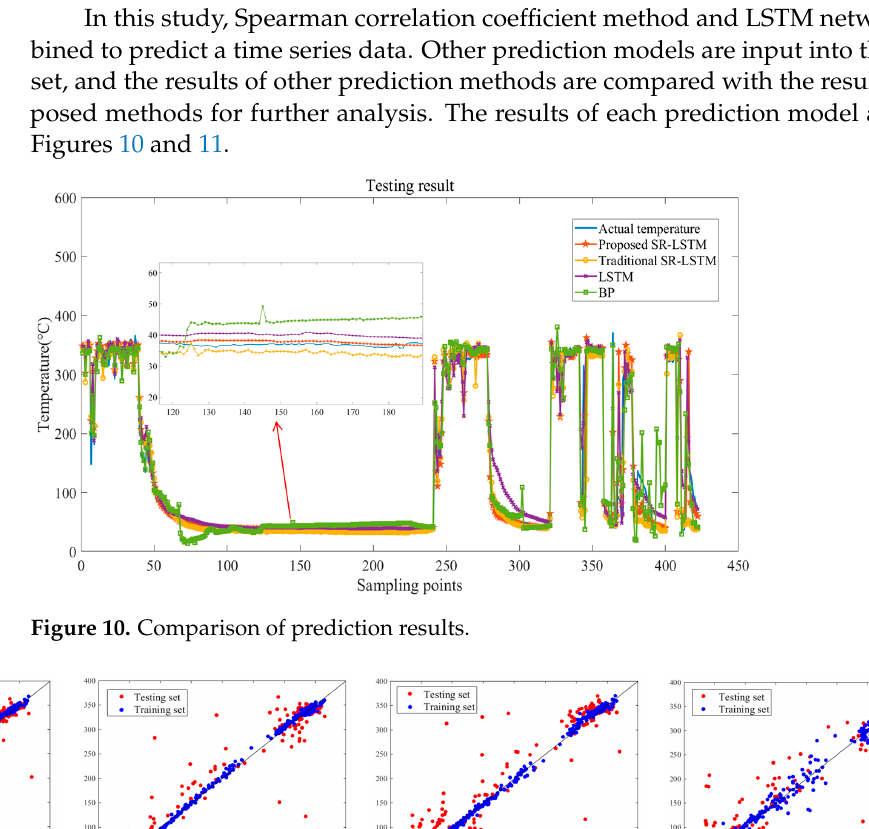
Figure 9. Model prediction outcomes.